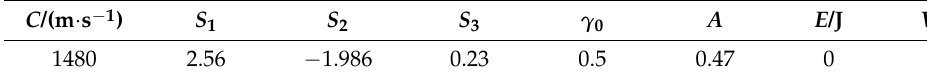
Table 6. State equation parameters of water.